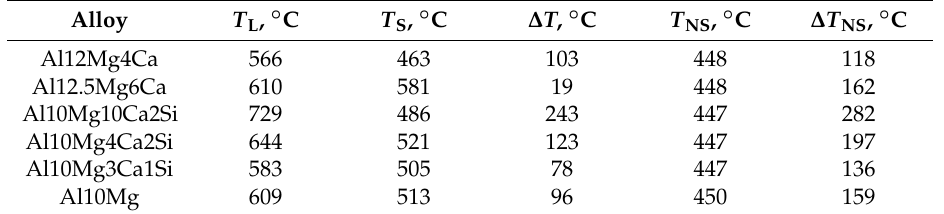
Table 4. Calculated critical temperatures of selected alloys of the Al-Ca-Mg-Si